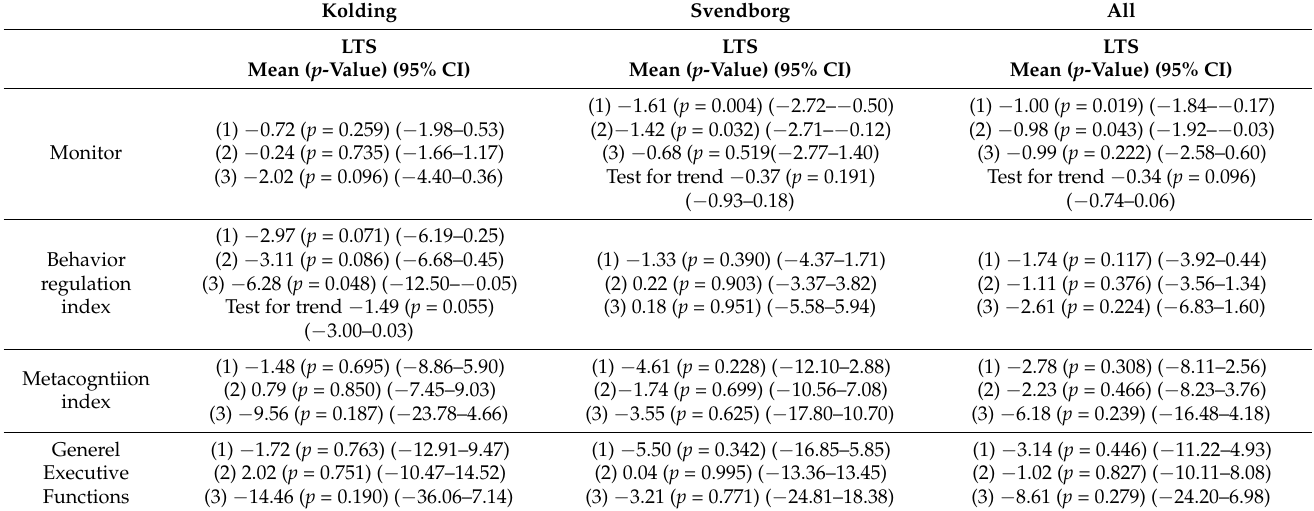
Table 4. FLANKER—Results from Kolding & Svendborg and all together. Results are presented